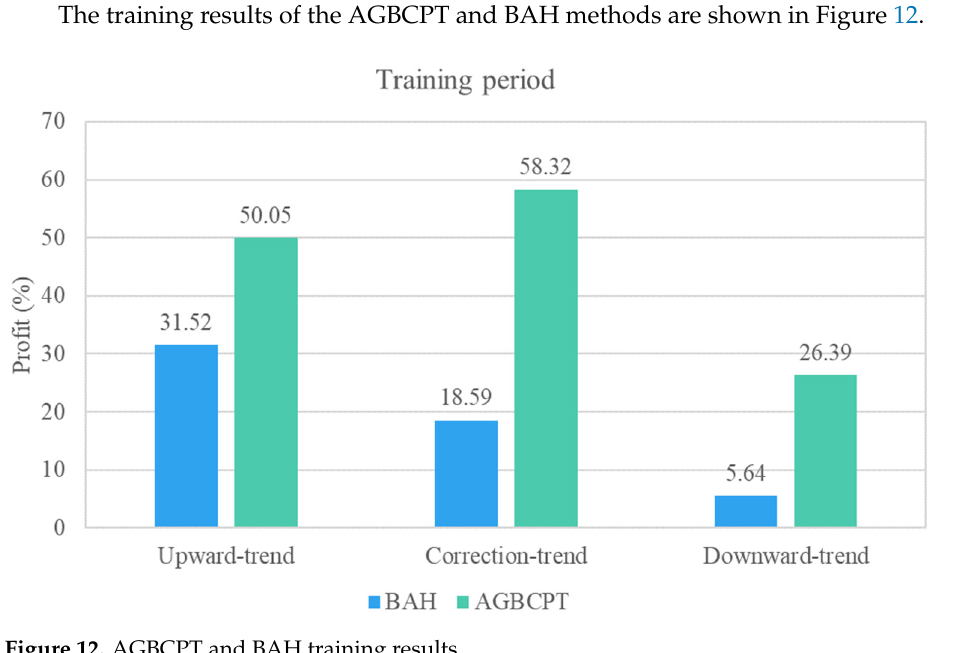
Figure 11. Taiwan stock market trends.